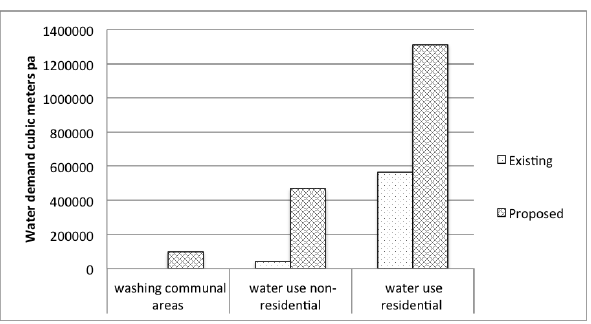
Figure 6. Comparison of existing and proposed water demand by different users. The reduction in site coverage and the taller, but fewer, buildings results in a decrease in overall